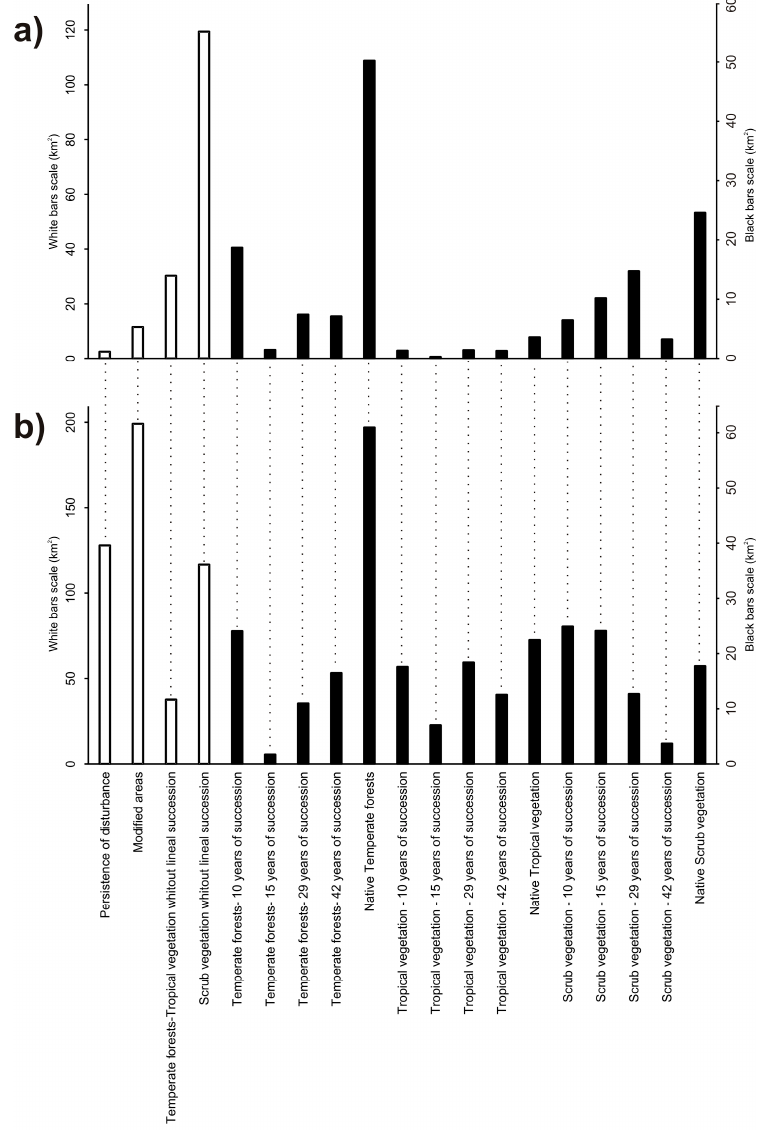
Figure 5. Occupied area (km 2 ) for each successional category in 2015 within the ( a ) Natural Protected Area Altas Cumbres and ( b ) its adjacent area. Victoria, Tamaulipas, Mexico.